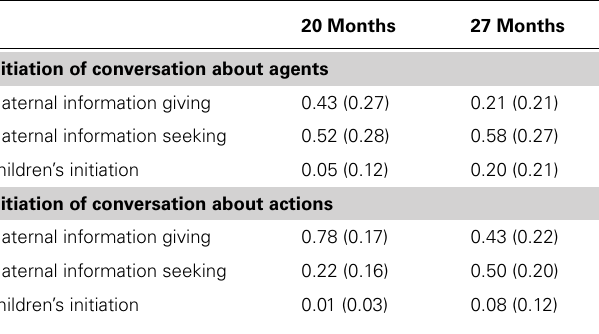
Table 2 | Mean proportions of initiation types (SDs in parentheses).